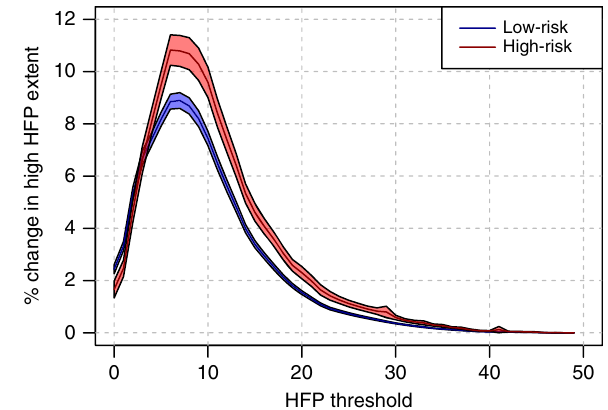
Fig. 4 Changes in the overlap between species ranges and high human footprint values over time. The lines report the average change in the overlap between species ranges and human footprint values bigger than any given threshold. Different lines refer to species in the low-risk or high- risk categories, as reported in legend. The shaded areas around the lines represent the 95% standard credible interval measured across a total of 4421